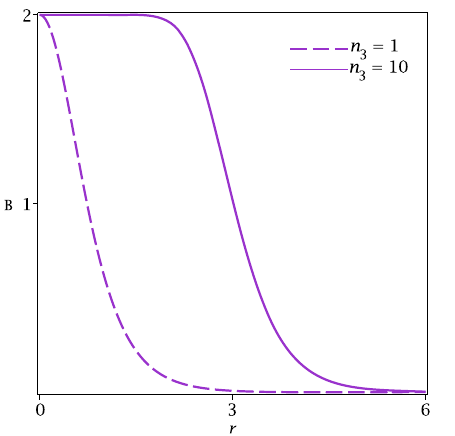
Fig. 4 Solutions of (18) for generalized permeabilities μ 1 = 1, μ 2 = | ϕ | 2 and μ = 2 −| ϕ | 2 . In the left, we show the solution profiles g 1 3 2 (red) and a 3 ( r )/ n 3 (blue). In the right, we depict the corresponding energy densities ρ 3 ( r ) . The cases n 3 = 1 (dashed line) and n 3 = 10 (solid line) are shown